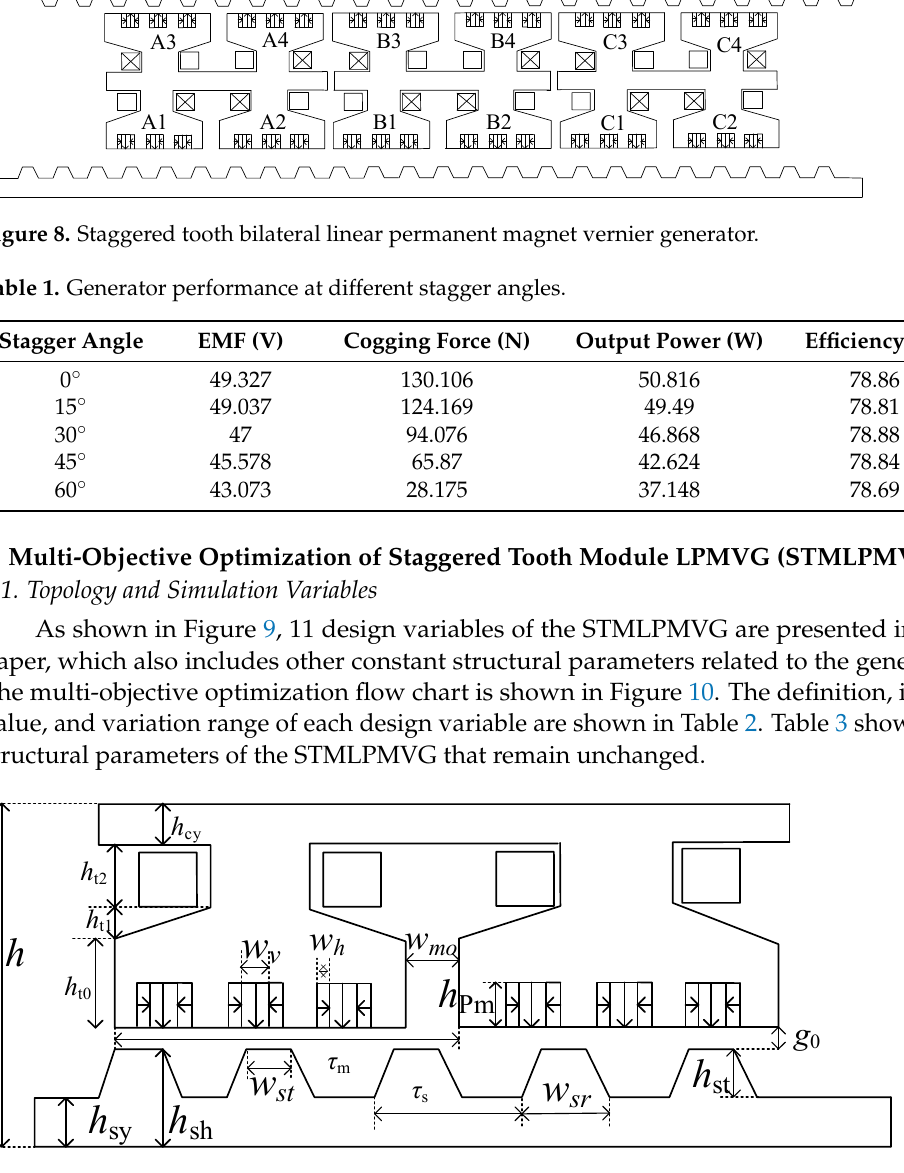
Figure 10. Multi-objective optimization flow chart.